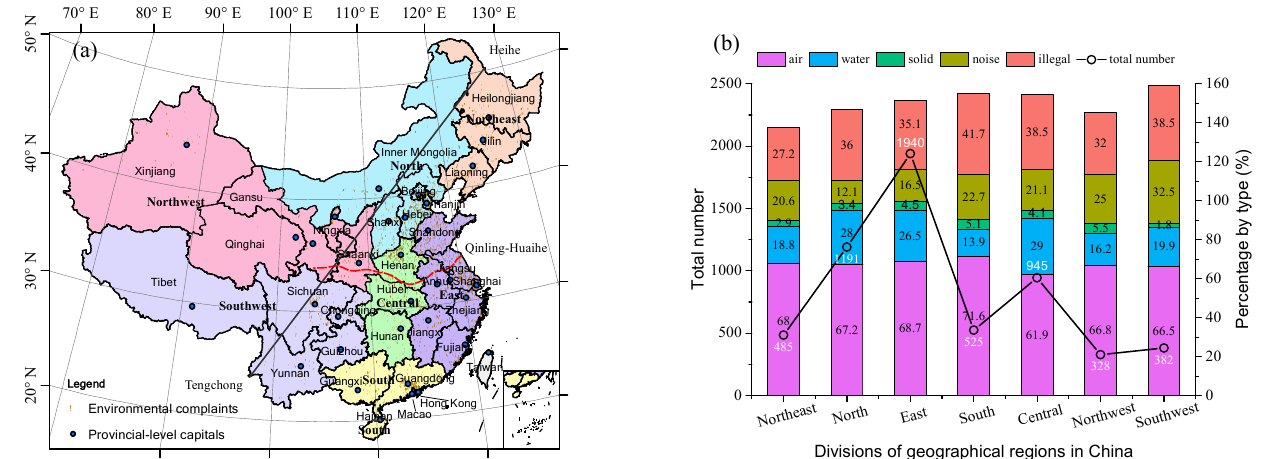
Figure 2. Spatial distribution of citizen environmental complaints. ( a ) Spatial division of China’s geographic regions and spatial visualization of all geocoding cases. ( b ) Spatial distribution of different types of environmental problems for each geographic region in China.